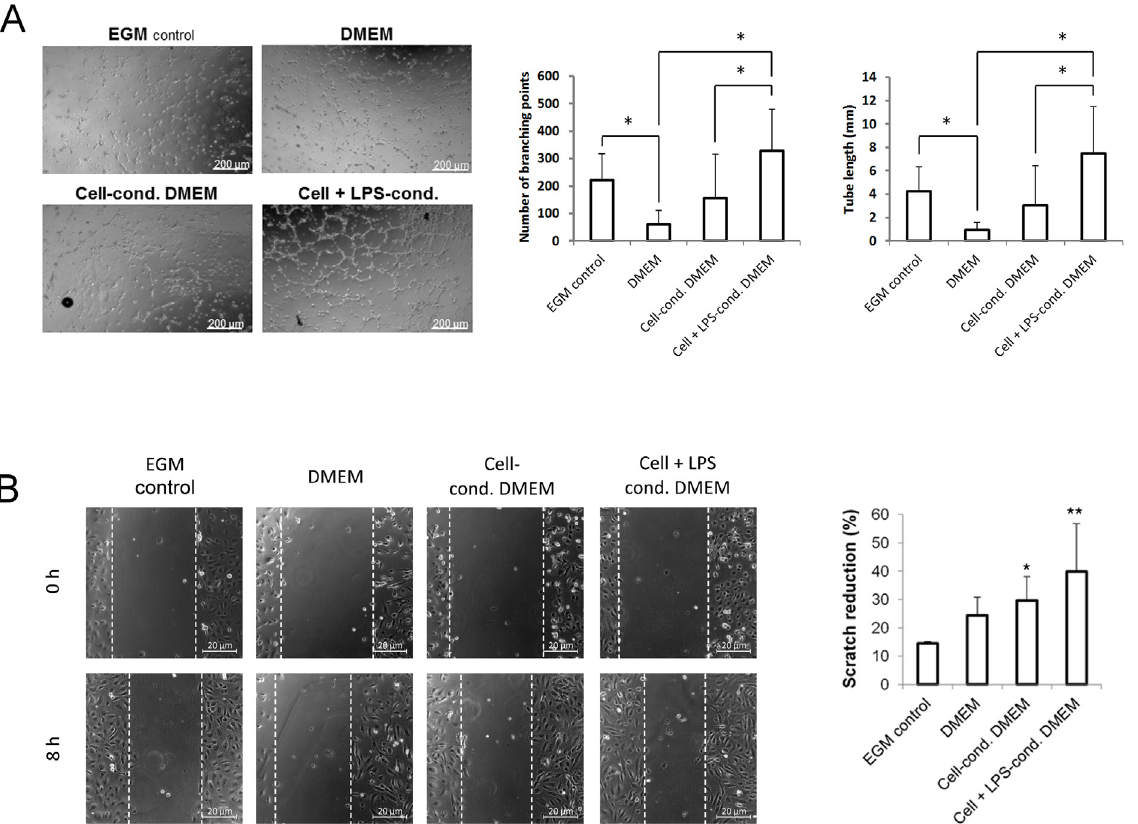
Fig 4. Tube formation and migration of LPS-stimulated SDSC. Human umbilical vein endothelial cells (HUVEC) seeded on Matrigel formed capillary-like structures under the influence of endothelial growth medium (EGM), cell-conditioned DMEM and even more in LPS-treated cell-conditioned DMEM. This effect could not be observed in the DMEM itself (A). In a scratch assay the same media were used showing a significantly higher migration rate when conditioned media were used (B). * p < 0.05, ** p < 0.01, *** p <